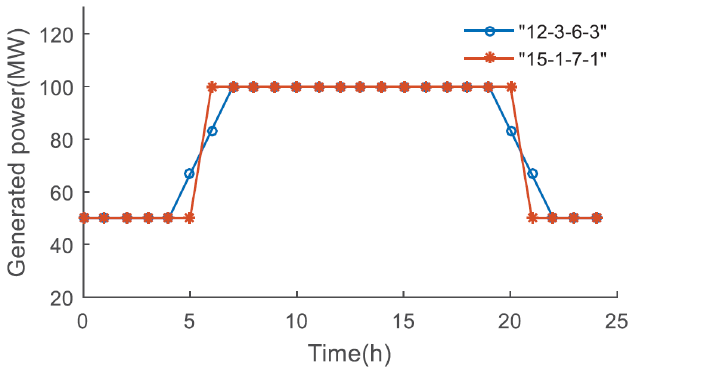
Figure 1. Two nuclear power generation load following